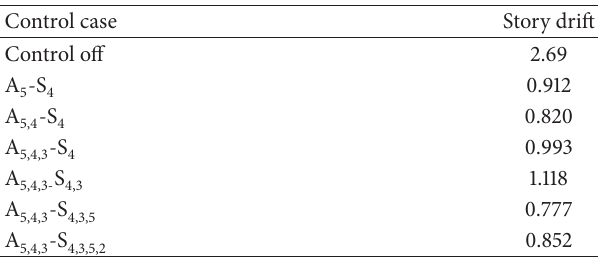
Table 7: The story drift of the fifth floor for the five-story shear building subjected to the harmonic